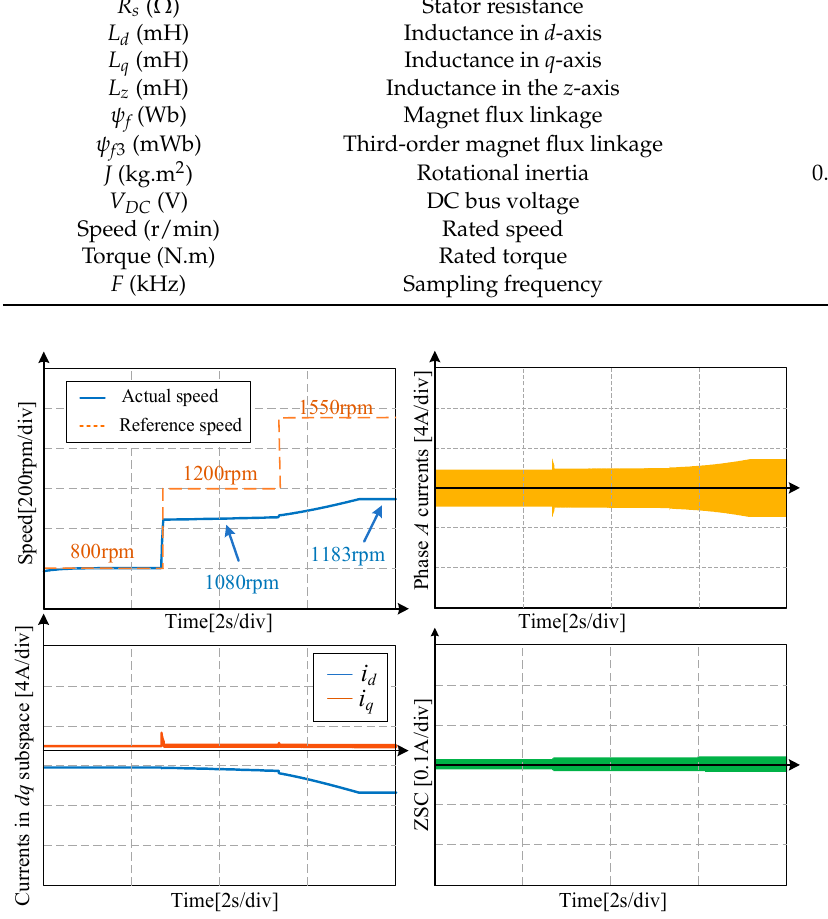
Figure 11. Simulation dynamic performance of the conventional fl ux-weakening controller.